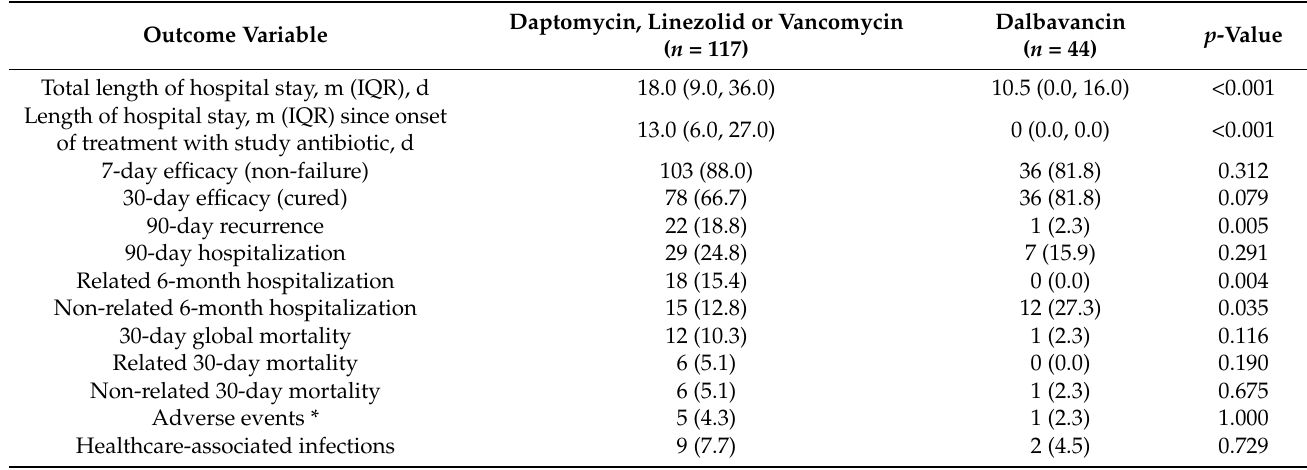
Table 2. Bivariate analysis of outcome variables for patients treated with dalbavancin (cases) versus those treated with other conventional antimicrobial therapies (daptomycin, linezolid, and vancomycin) (controls). Daptomycin, Linezolid or Vancomycin Dalbavancin p -Value Outcome Variable ( n = 117) ( n = 44) Total length of hospital stay, m (IQR), d 18.0 (9.0, 36.0) 10.5 (0.0, 16.0)